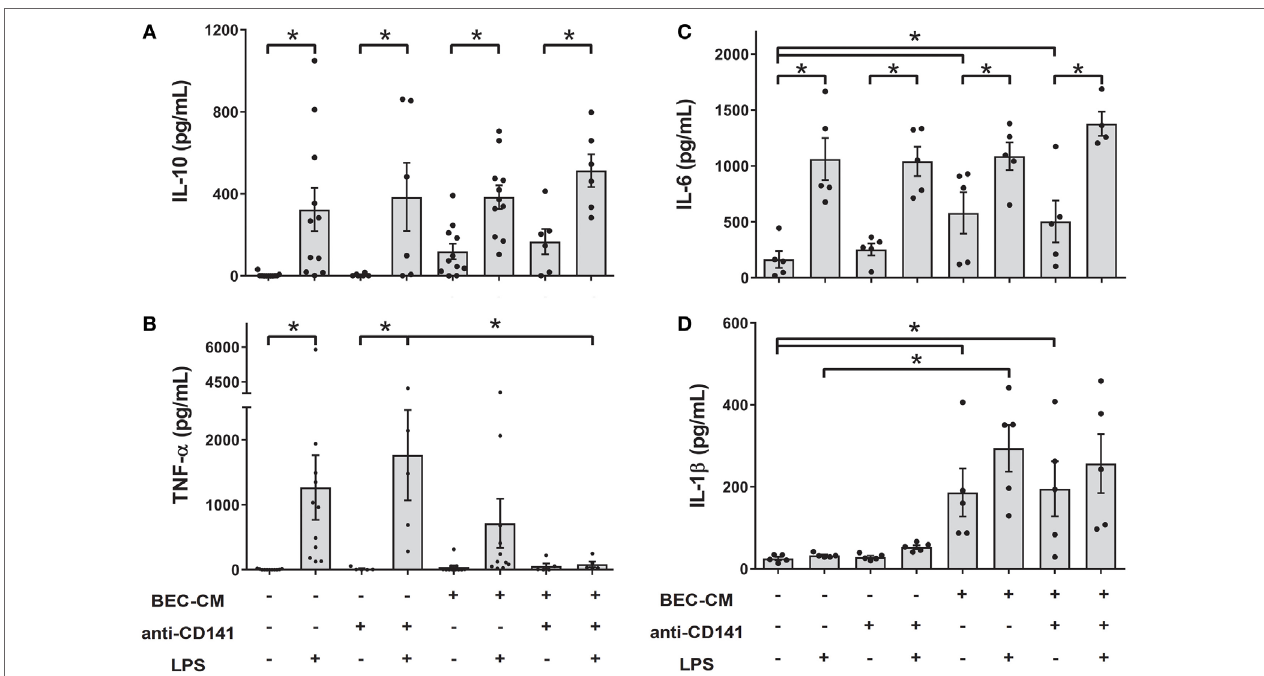
FigUre 6 | ligation of cD141 in the bronchial epithelial cell-conditioned media (Bec-cM) environment suppresses the release of TnF- α when stimulated by lipopolysaccharide (lPs) . Monocytes were cultured for 48 h with medium alone or with BEC-CM in the presence of the anti-CD141 antibody (0.5 µg/mL) or 0.5 µg/mL mouse IgG1 isotype control. Cells were stimulated with LPS (100 ng/mL) for the last 24 h. The secretion of cytokines was analyzed using the Luminex system: (a) IL-10, (B) TNF- α , (c) IL-6, and (D) IL-1 β . Data are expressed as means ± SEM of at least five independent experiments. Statistical analysis was performed using analysis of variance test (followed by the Fisher LSD test) (* P <